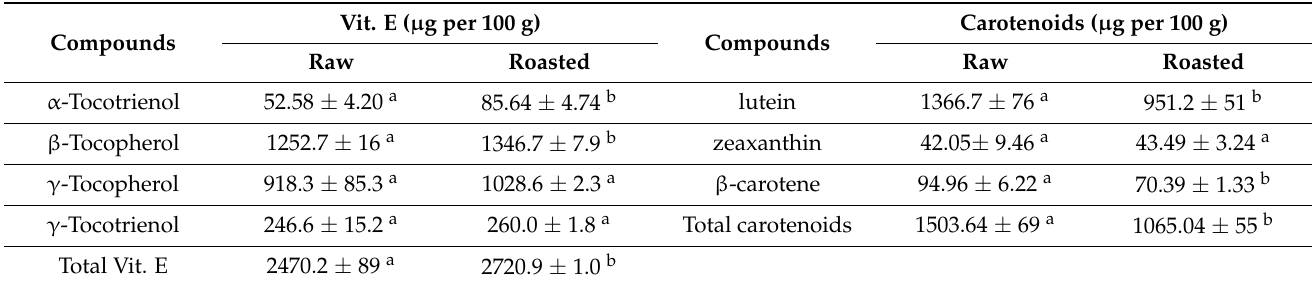
Table 3. Vitamin E and carotenoids profiles of pistachios (raw and roasted) (independent T-test).